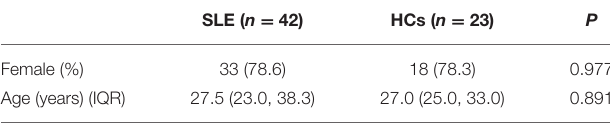
TABLE 1 | Demographic of SLE and HC